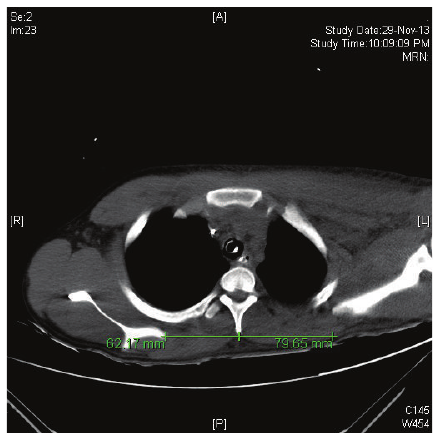
Figure 2: Axial CT section revealing the increase in distance between medial border of left scapula and the spinous process of the fourth thoracic vertebra.